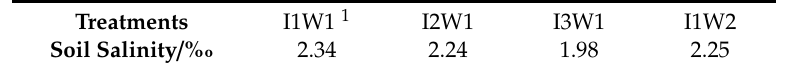
Table 4. Soil salinity in di ff erent irrigation